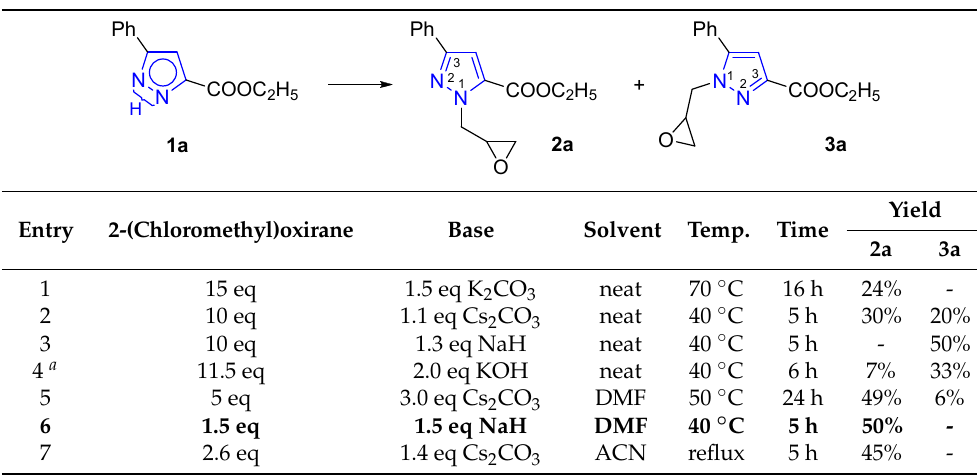
Table 1. Optimization of reaction conditions to access 2a .